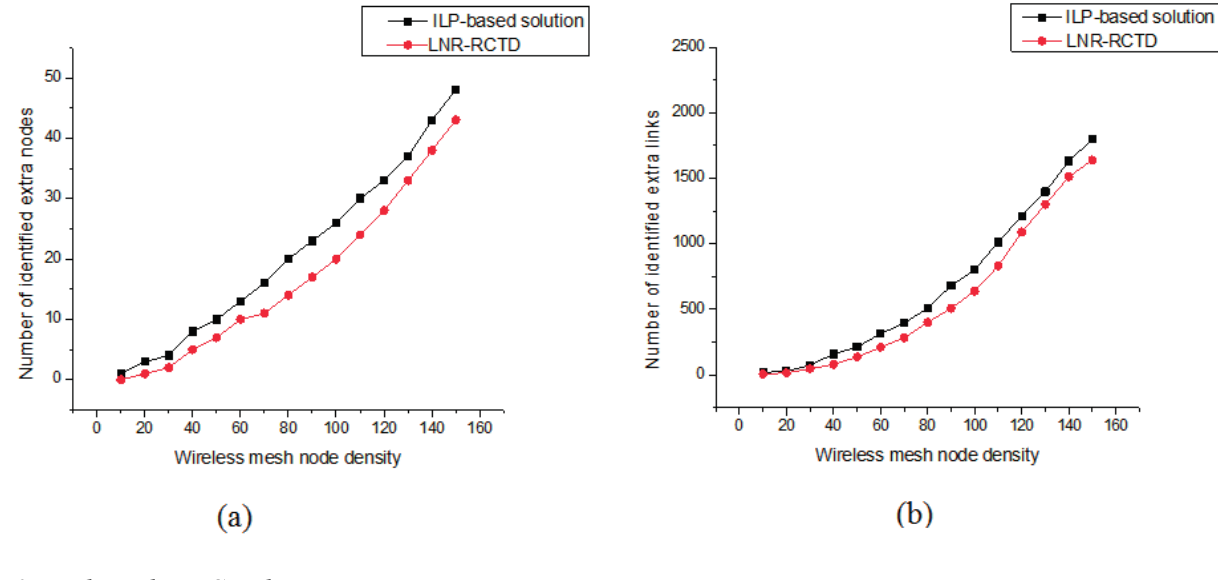
Figure 6. ( a ) Identification of extra mesh nodes; ( b ) Identification of extra wireless